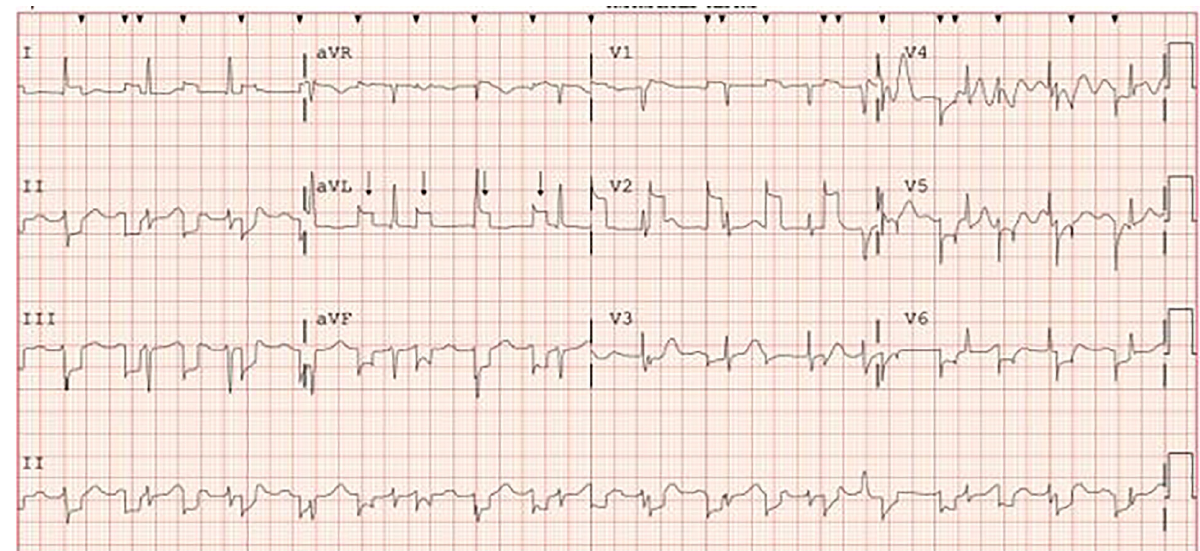
Image 1. Electrocardiogram, demonstrating a fixed frequency square wave artifact